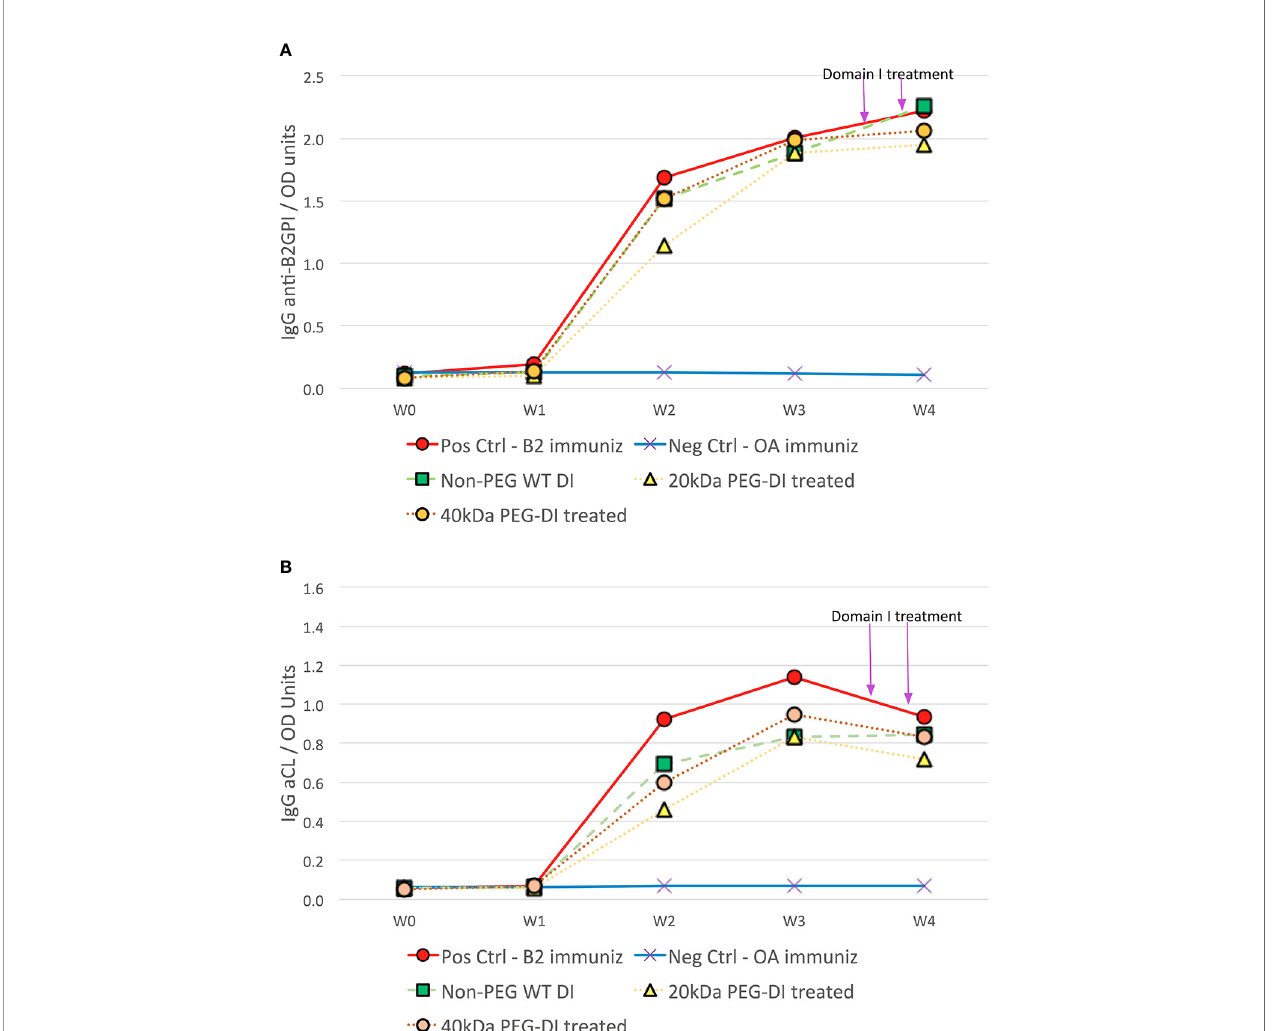
FIGURE 1 | Antiphospholipid antibody development in chronic mouse model of APS disease. CD1 mice immunized with b 2 GPI produced signi fi cant titers of anti- b 2 GPI (A) and aCL (B) over the 4-week period compared to corresponding OA immunized negative controls. At the time of thrombus surgery at week 4, aCL and anti-